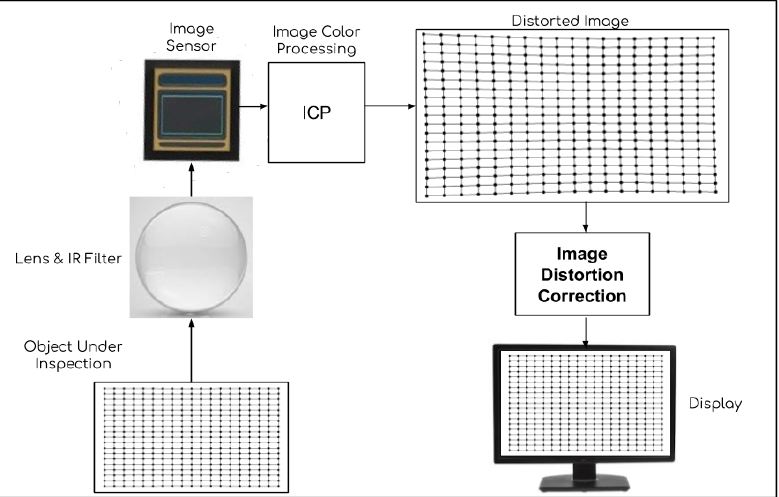
Figure 14. Microscope image distortion processing pipeline.